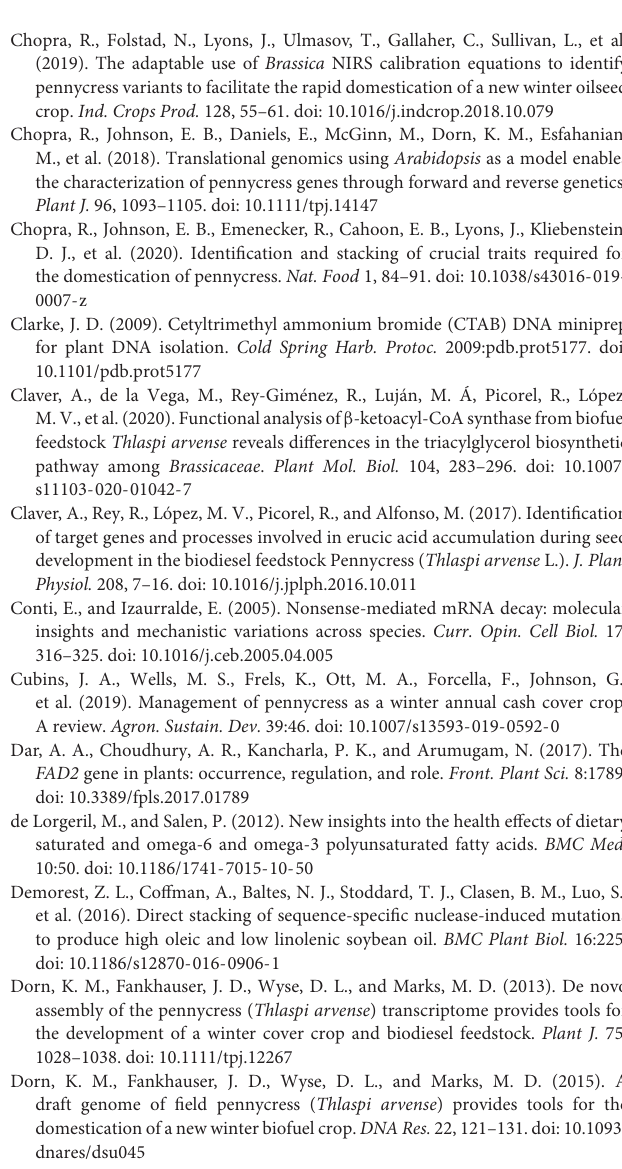
Supplementary Figure 1 | Nucleotide sequence alignment of the AtFAD2 and TaFAD2 ORFs. Supplementary Figure 2 | T7 endonuclease analysis and sequences of the fad2 mutants. Supplementary Figure 3 | Nucleotide sequence alignment of the AtROD1 and TaROD1 ORFs. Supplementary Figure 4 | Sequences of the rod1 mutants. Supplementary Figure 5 | Pictures of mutants and wild type growth over time.